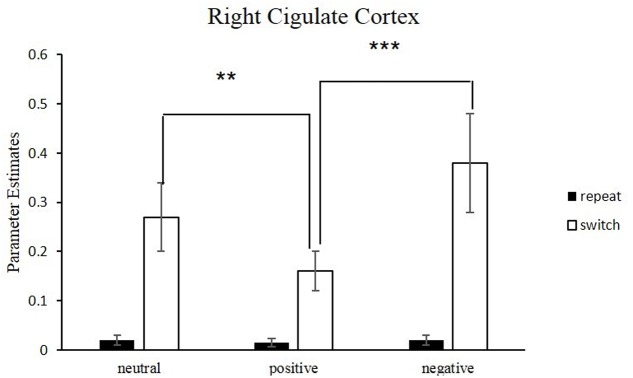
Neural correlates underlying switch vs. repeat conditions for different emotional conditions. Error bars indicate the standard deviation. Conditions denoted by two asterisks indicate significant difference between them (∗∗p < 0.01; ∗∗∗p < 0.001).